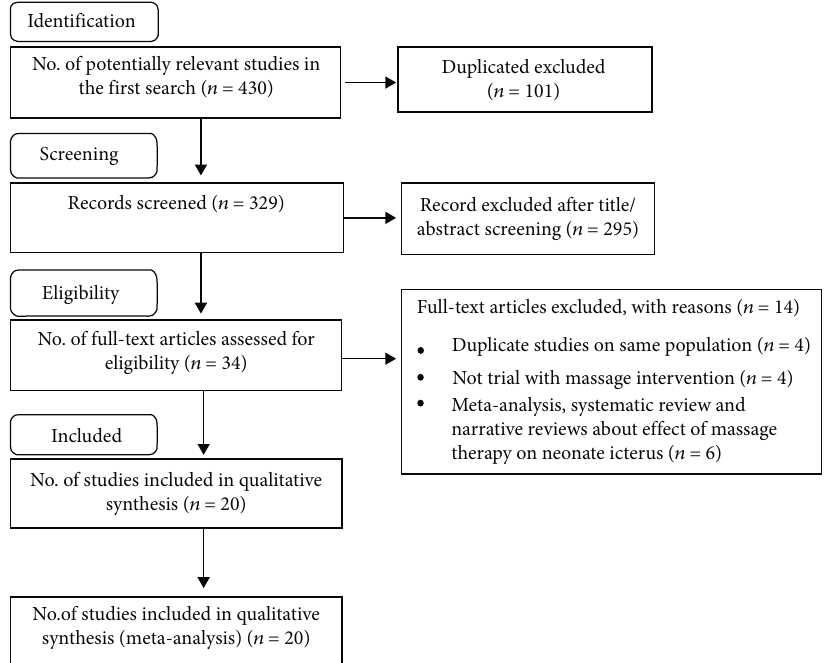
Figure 1: Flow diagram of the study selection process including publications for the dose-response meta-analysis of massage therapy and neonate